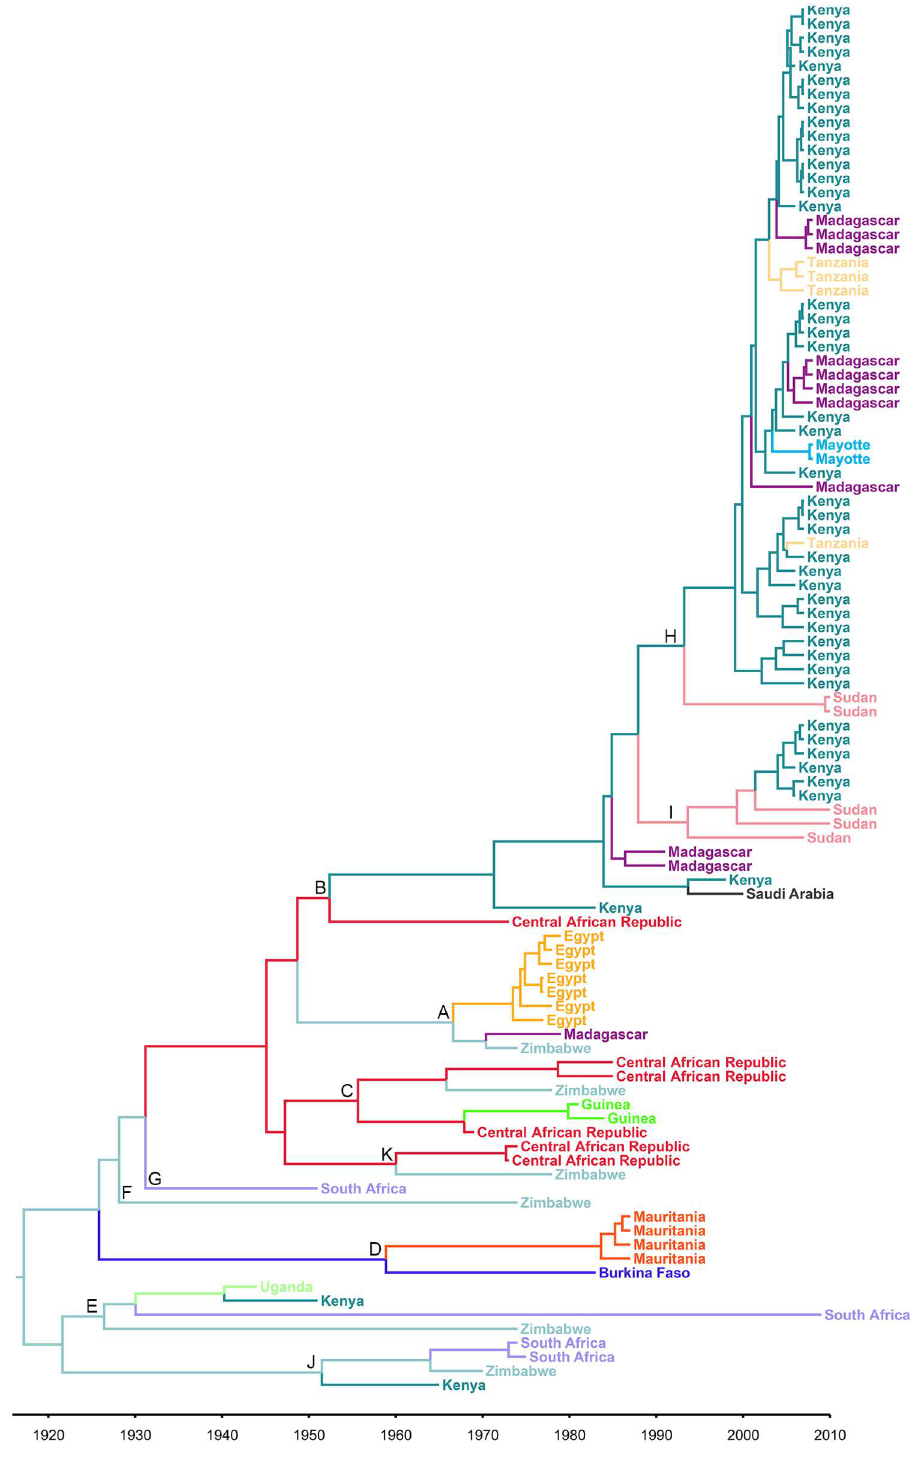
Fig 3. Maximum Clade Credibility tree based on all sequences of the medium minigenomic segment (M) of RVFV isolates in the study. Country of origin is indicatedby color of the tree branches and branch tips. An onlineversion of the tree is availablevia https://figshare.com/s/1efd1db044bcaa9e35a9.